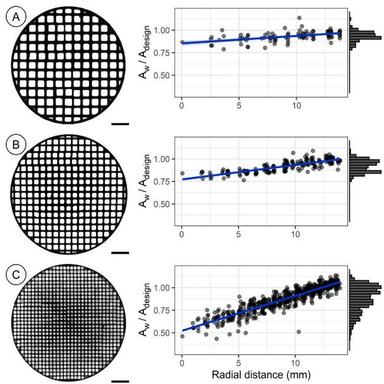
Dimensional characterization of parts with different unit cell scale, fabricated from a fully-loaded print (3 selected parts, n = 1). From left to right: reconstructed micrograph, normalized window area as a function of radial distance from the part core, and histogram of normalized window area. (A) 1.86 mm window length, (B) 1.3 mm window length, (C) 0.74 mm window length. Scale bar is 5 mm.